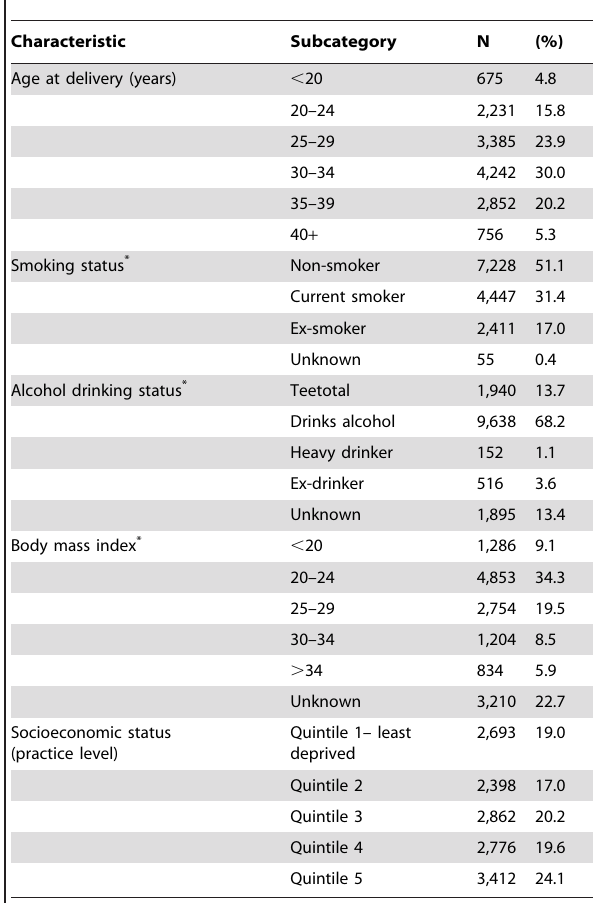
Table 2. Population characteristics for the cohort